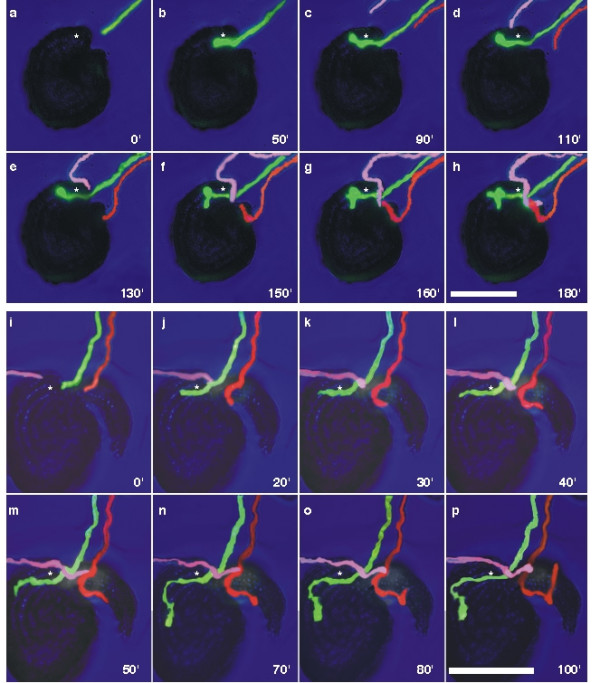
Pollen tubes avoid targeted ovules. Two examples (a–h and i–p) of pollen tube avoidance by ovules approached by three pollen tubes (false colour: green, the tube that enters the micropyle (*); pink and red, tubes that arrive later and do not enter; entire set of original images are presented in Additional Files 3 and 4). Elapsed time in minutes; Scale bars, 100 μm.